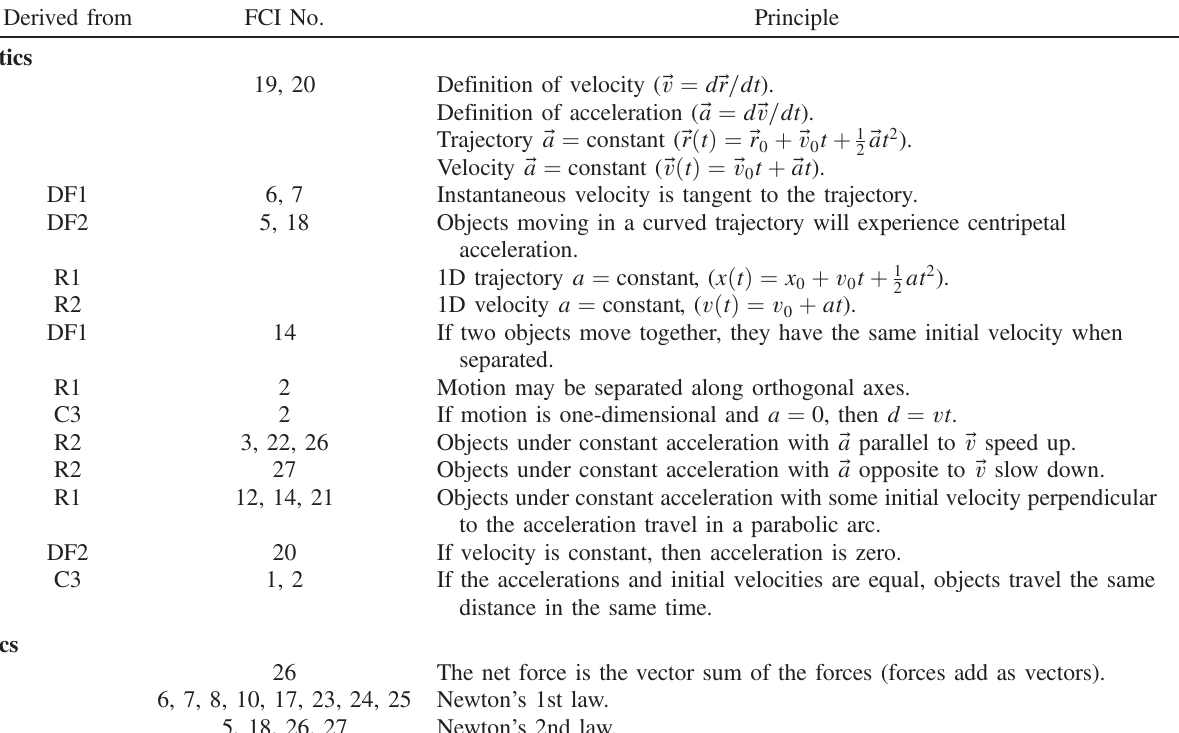
TABLE III. Theoretical model of Newtonian mechanics as tested by the FCI. Principles in bold were included in the optimal model 3 fitting the reduced